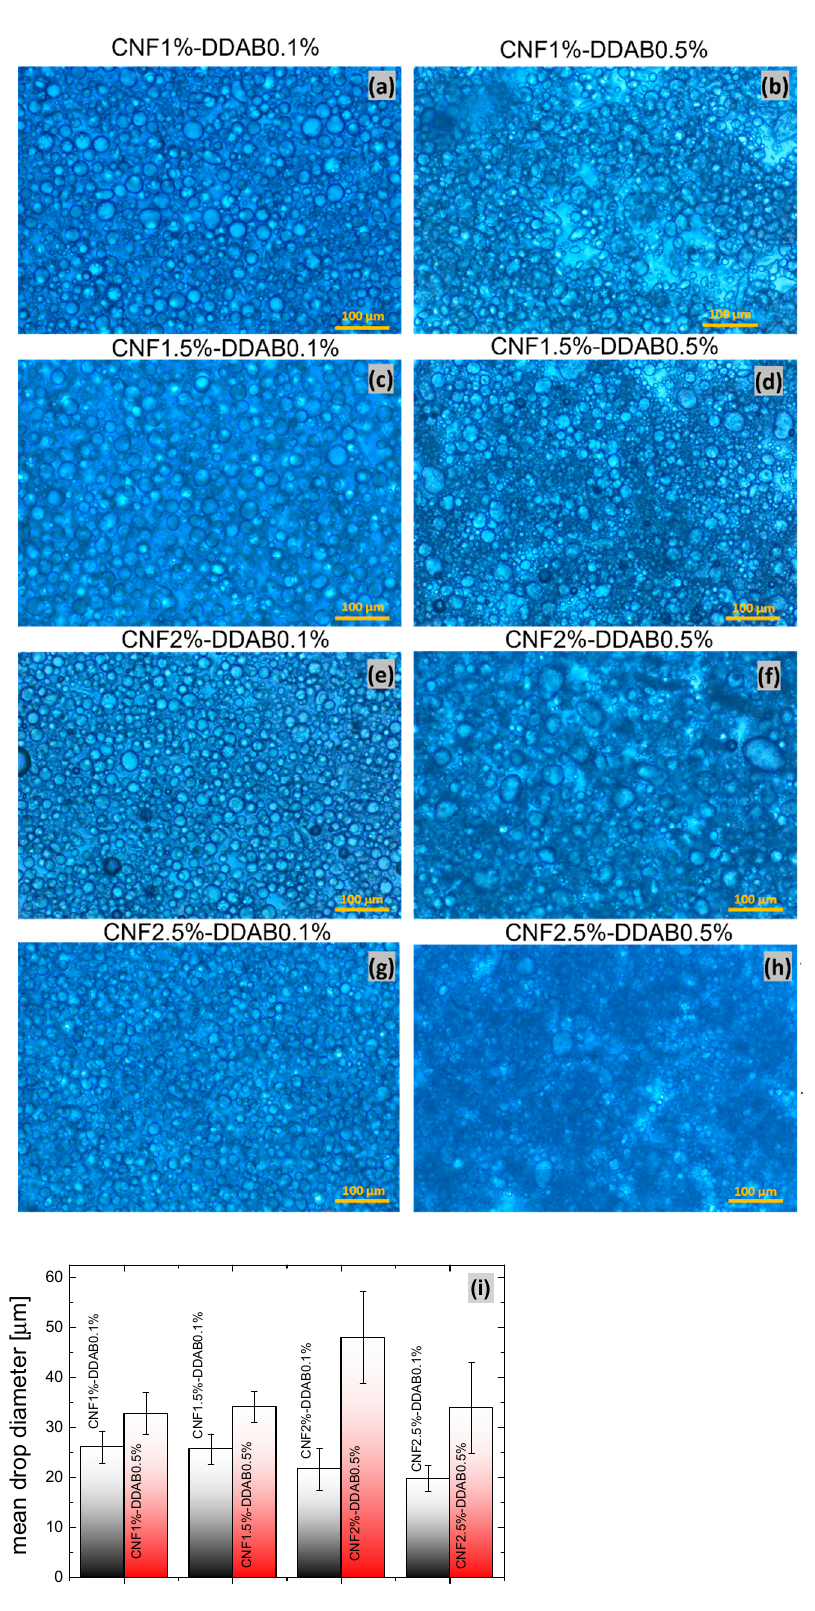
Figure 2. Optical microscopy characterization of ( a , b ) CNF1%-DDAB0.1 and 0.5%, ( c , d ) CNF1.5%- DDAB0.1 and 0.5%, ( e , f ) CNF2%-DDAB0.1 and 0.5%, and ( g , h ) CNF2.5%-DDAB0.1 and 0.5%. Con- trast adjusted for improved visibility. ( i ) Column graph concerning the droplets’ mean size. Sizes were determined by Image J.